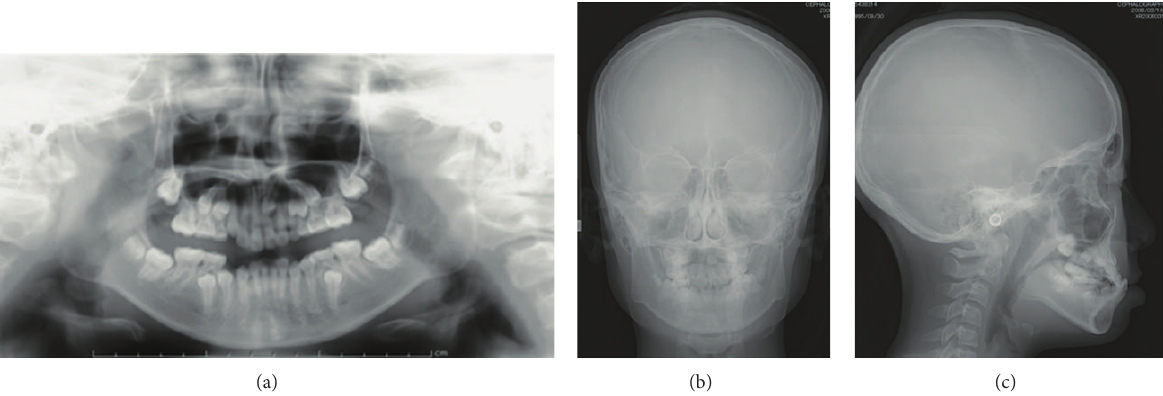
Figure 2: Radiographic appearance at the age of 12 years and 6 months: (a) panoramic radiograph, (b) frontal cephalometric radiograph, and (c) lateral cephalometric